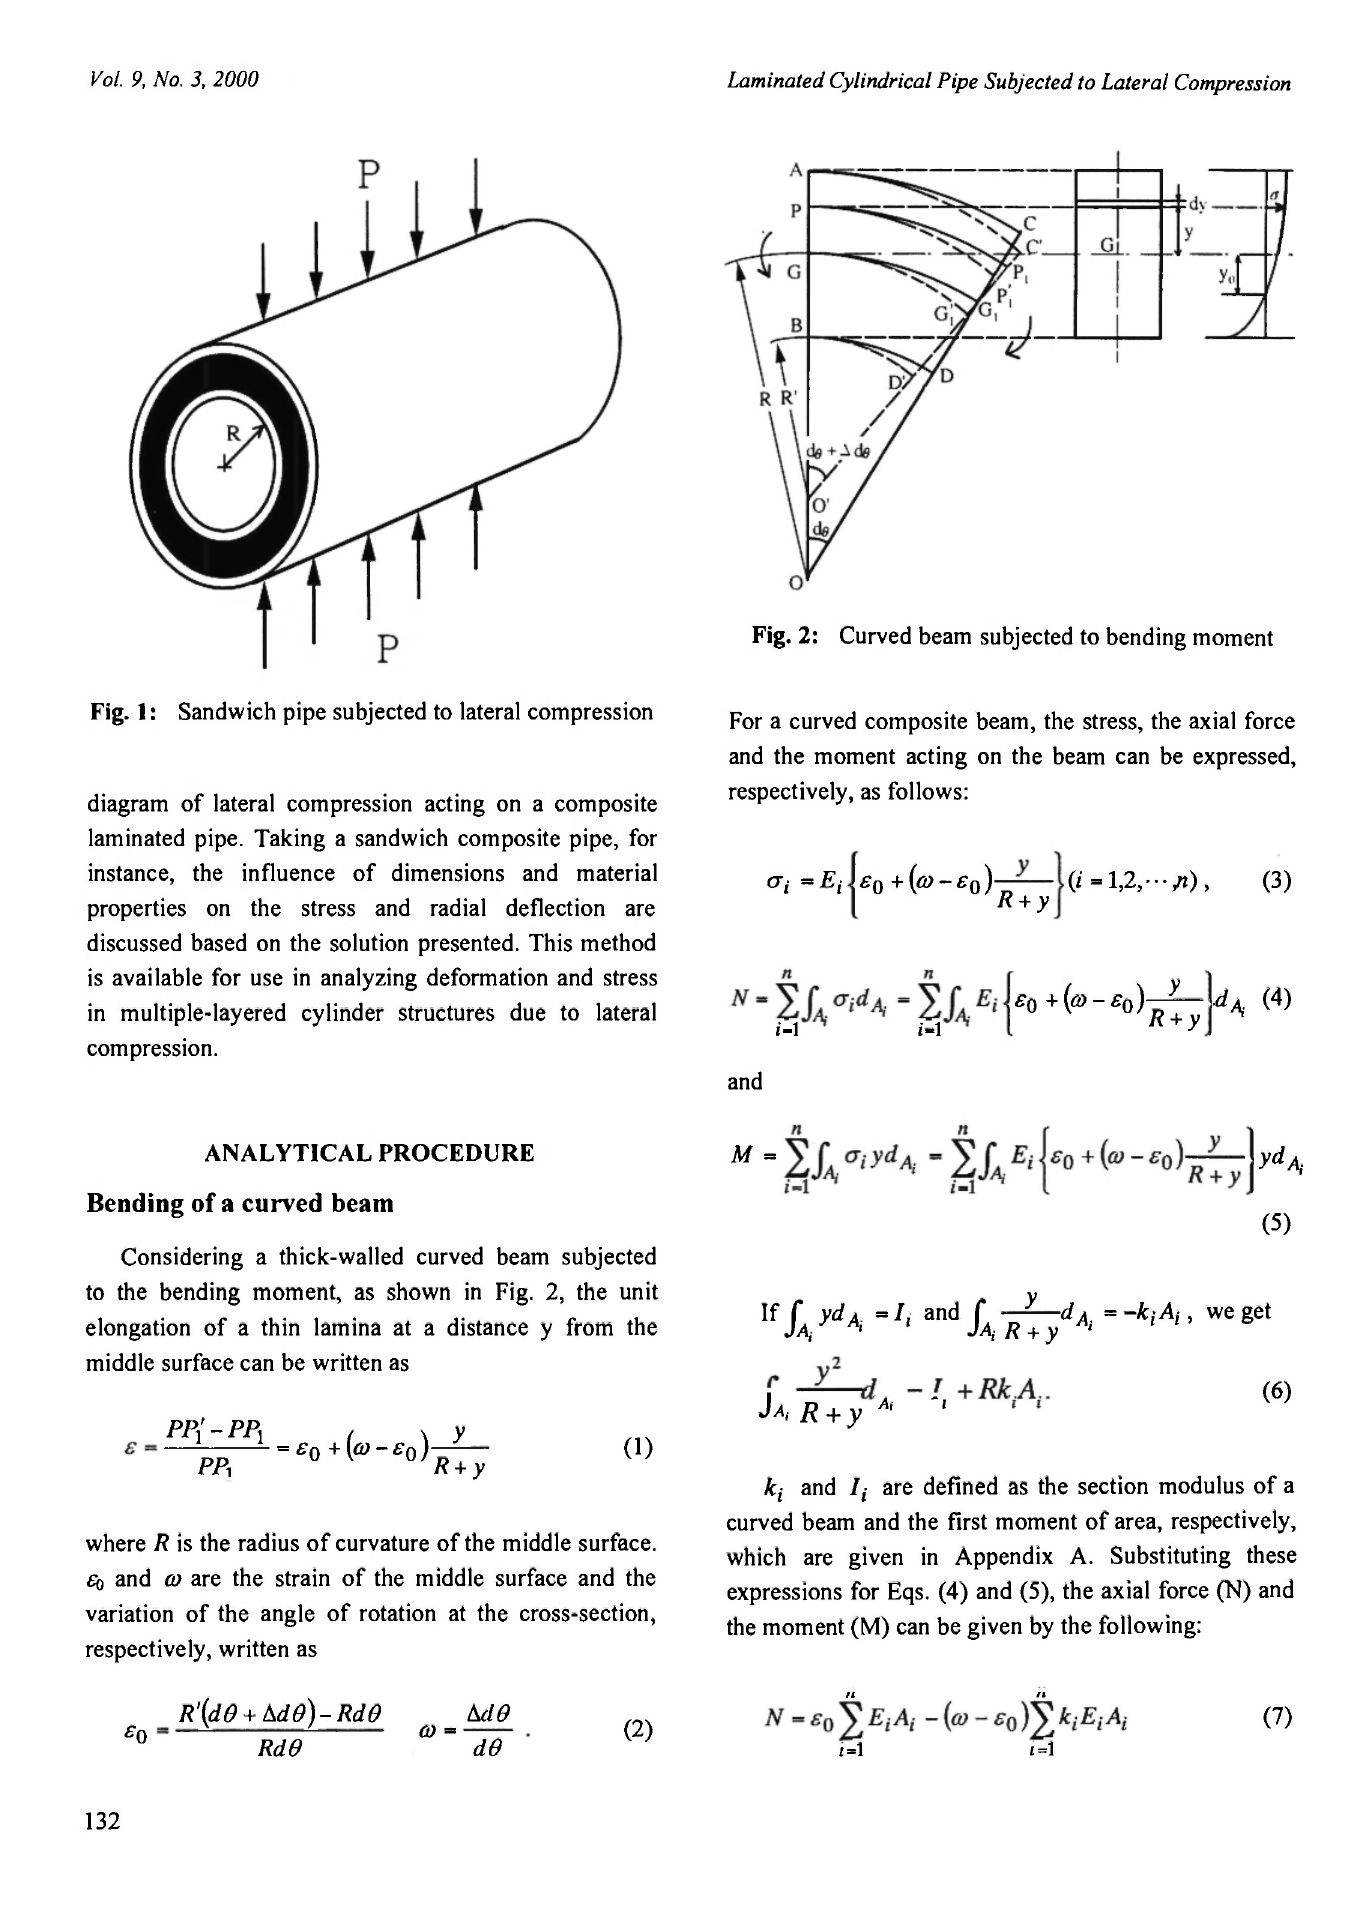
Fig. 1: Sandwich pipe subjected to lateral compression